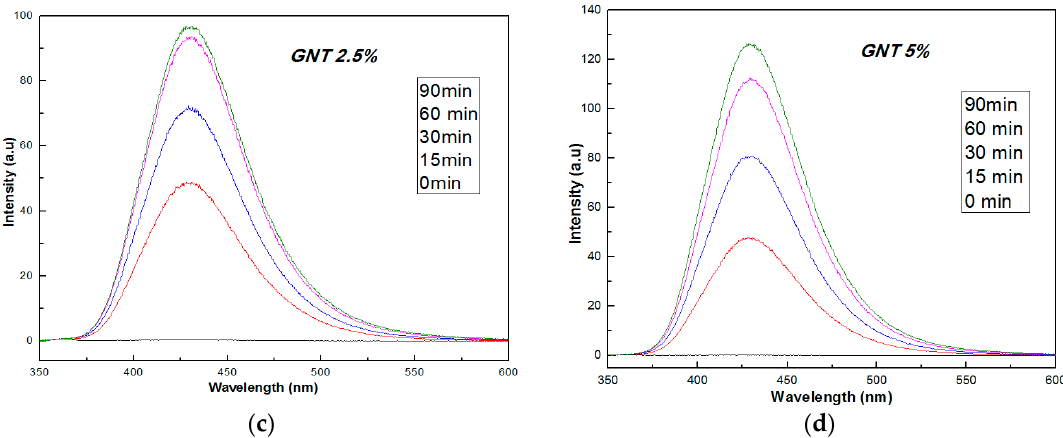
Figure 8. Fluorescence spectra of hydroxy-terephthalic (OHTA) formation of prepared fibers ( a ) TiO 2 , ( b ) GNT 1%, ( c ) GNT 2.5%, ( d ) GNT 5%.